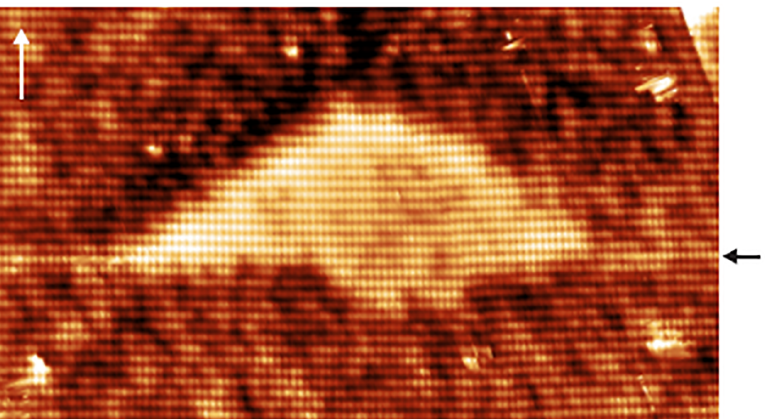
Figure 7. 38 × 23 nm 2 topographic image of a QD with a GaAs rich etch pit in the AlGaAs buffer layer, taken at V b = − 3 V and I t = 40 pA. The growth direction and the position of the wetting layer are marked by white and black arrows respectively. Adopted from Ref. [93].